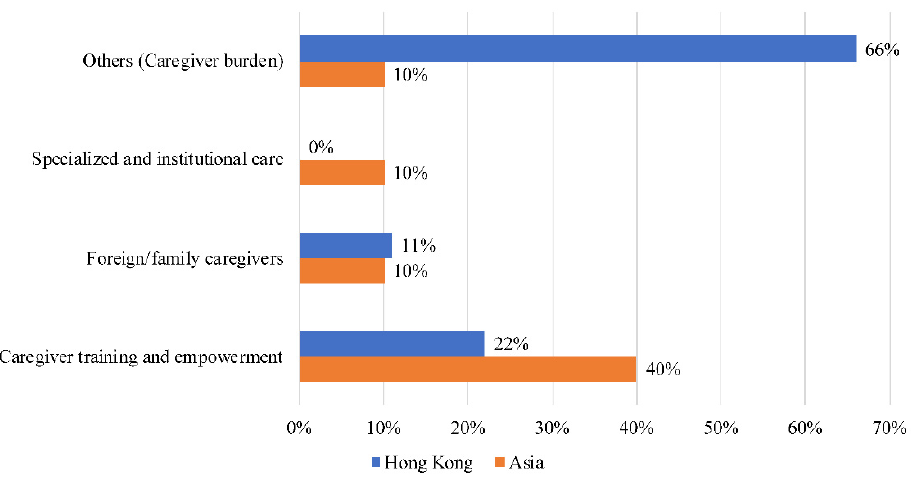
Figure 4. Societal narratives on caregivers in Hong Kong.